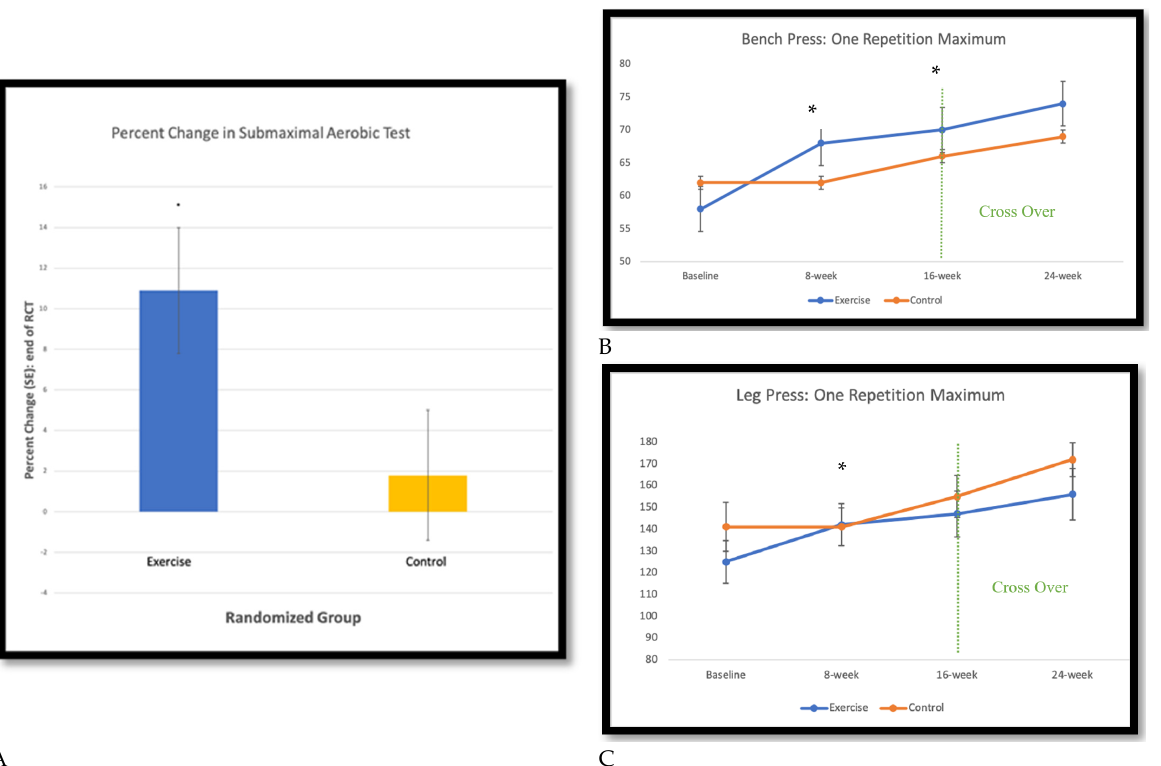
Figure 2. Findings for Functional Aerobic Capacity and Upper and Lower Extremity Strength Tests. ( A ) Percent change T0-T1: Functional Aerobic Capacity, * between group difference: p < 0.05; ( B ) Upper Extremity: Bench Press, * between group difference: p < 0.05; ( C ) Lower Extremity: Leg Press, * between group difference: p < 0.05.